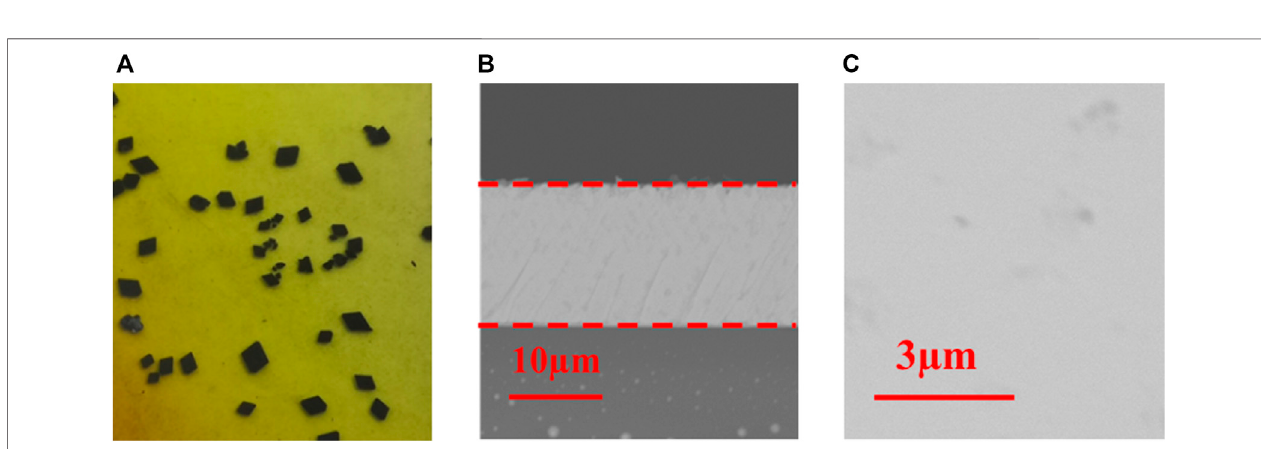
FIGURE 2 | (A) Photograph, (B) cross-sectional SEM images, and (C) surface morphology SEM images of a MAPb 0.5 Sn 0.5 I 3 single-crystal thin fi